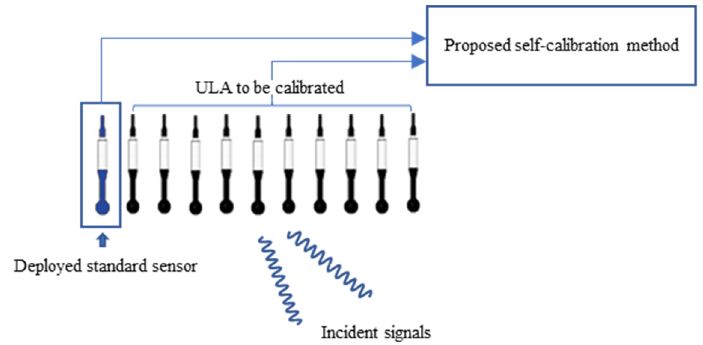
Figure 1. Structural diagram of the ULA to be calibrated and the deployed standard sensor.